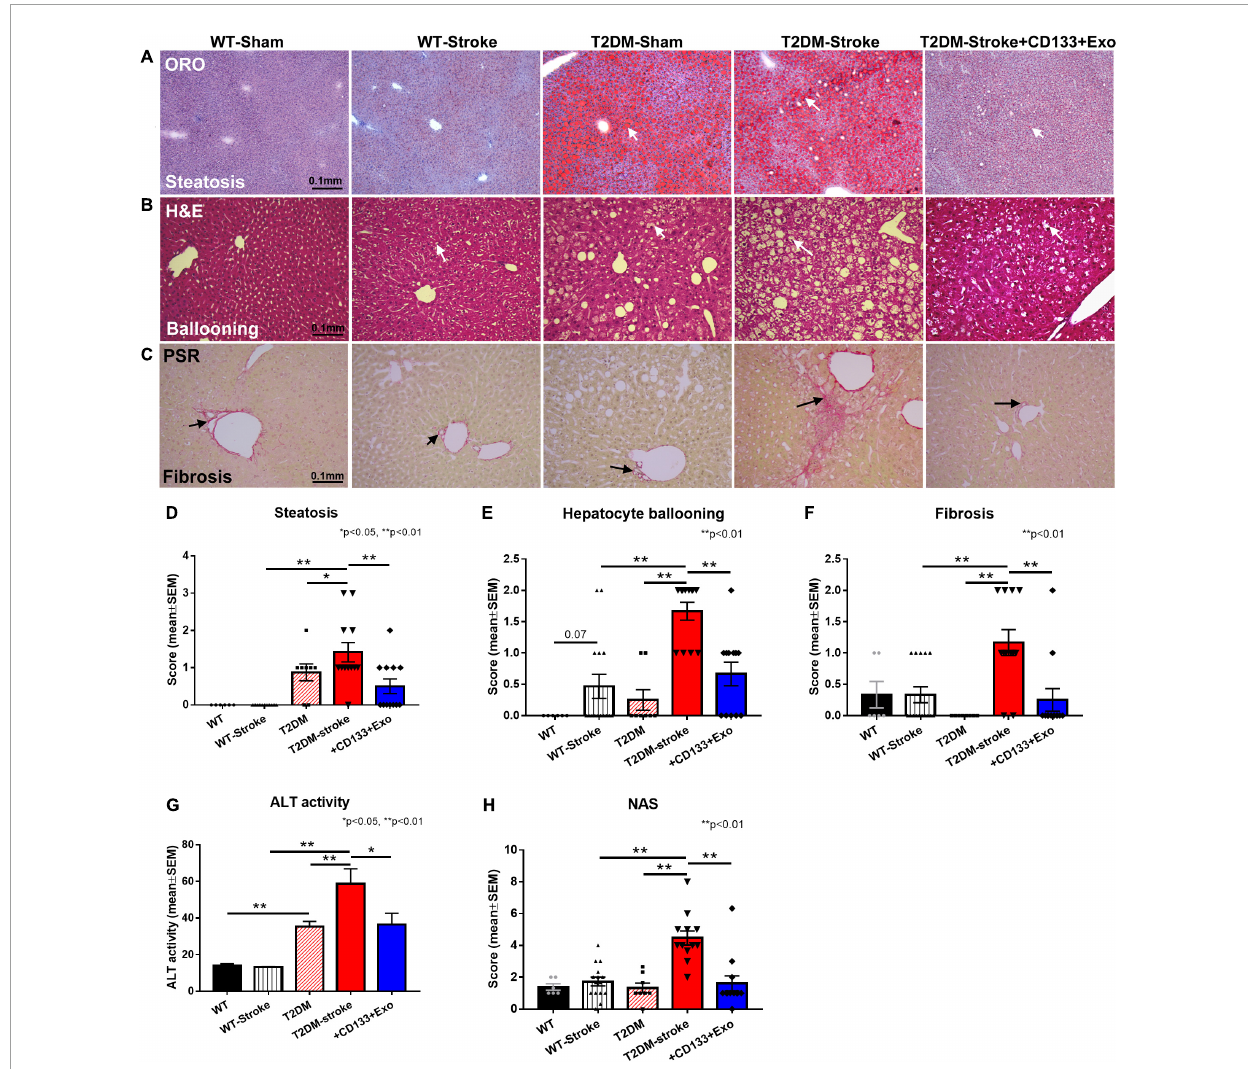
FIGURE4 Stroke in T2DM-mice exacerbates NAFLD progression while CD133 + Exo treatment significantly reduces steatosis, fibrosis, NAS, and ALT activity. (A–C) Representative images of Oil red O (ORO), hematoxylin and eosin (H&E) staining and PicroSirius Red (PSR). T2DM-stroke mice exhibit significantly increased liver steatosis (D) , increased ballooning degeneration of hepatocytes (E) , increased fibrosis (F) , increased serum ALT activity (G) , and higher NAS (H) compared to T2DM-Sham mice. CD133 + Exo treatment of T2DM-stroke mice significantly decreased liver steatosis, hepatocellular ballooning, fibrosis, serum ALT activity, and NAS compared to T2DM-stroke mice at 28 days after stroke. NAS is the unweighted sum of scores for steatosis (0–3), lobular inflammation (0–3) and hepatocellular ballooning (0–2). Non-DM (WT, n = 6), non-DM-stroke (WT-Stroke, n = 15), T2DM ( n = 8), T2DM-stroke ( n = 12), and T2DM-stroke + Exo ( n =